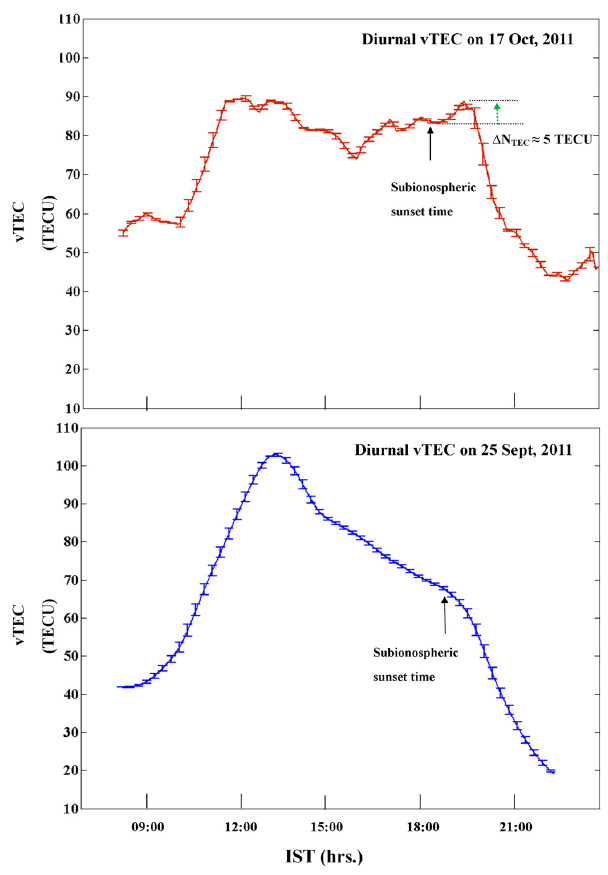
Fig. 11. Diurnal variation of average vTEC (for elevation > 50 ◦ ) on 17 October 2011 (scintillation day) and 25 September 2011 (non- scintillation day) indicating post-sunset enhancement of TEC fol- lowing subionospheric sunset time (IST) and no enhancement, re- spectively. Error bars on two plots represent standard deviation of the